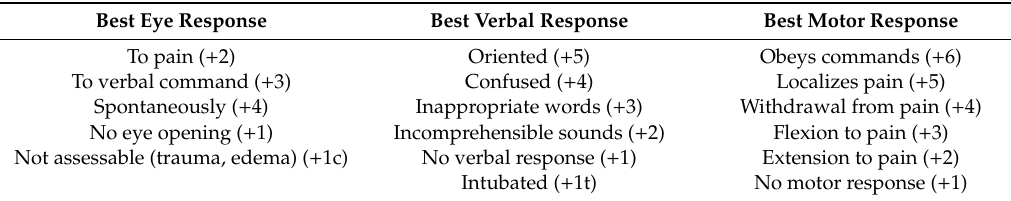
Table 1. Glasgow Coma Scale / Score